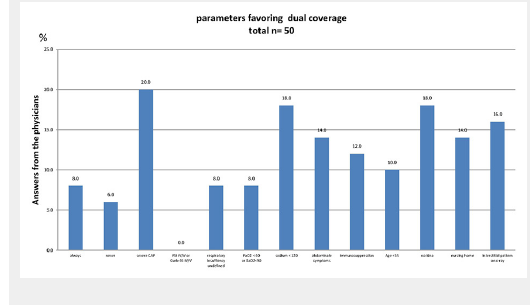
Answers from physicians: under what clinical circumstances should dual antibacterial therapy be prescribed for patients hospitalised with community-acquired